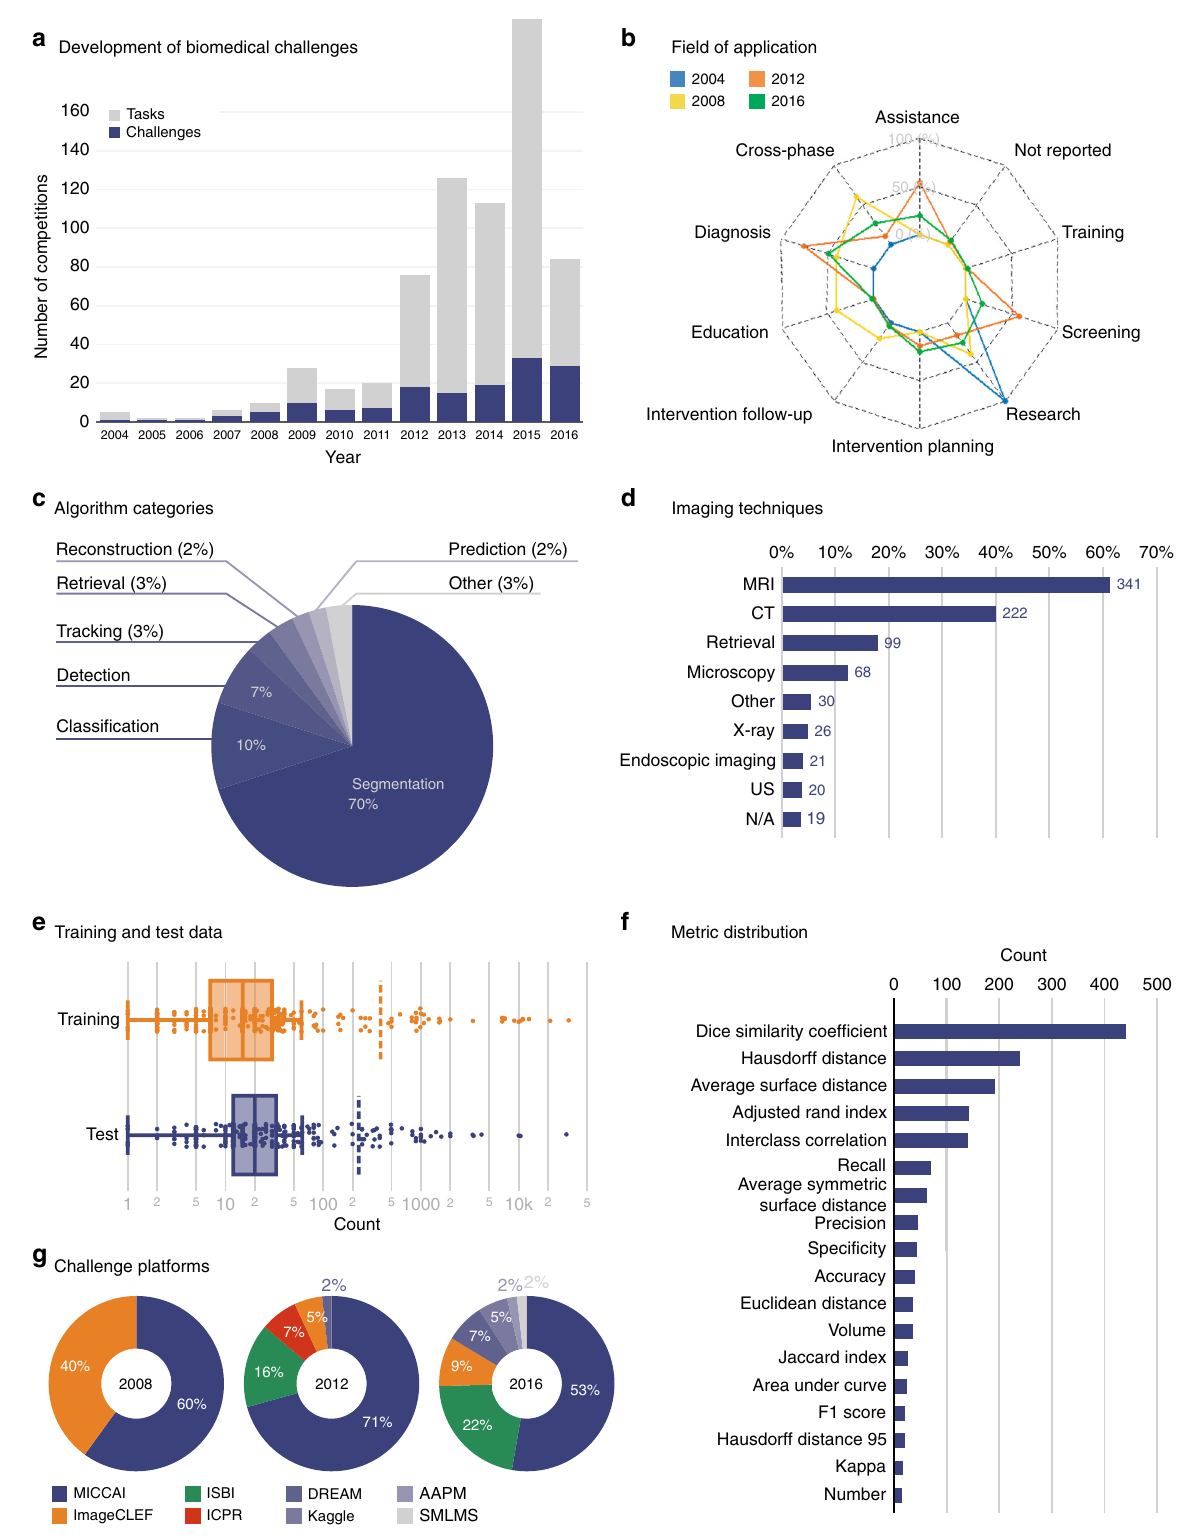
Fig. 1 Overview of biomedical image analysis challenges. a Number of competitions (challenges and tasks) organized per year, b fi elds of application, c algorithm categories assessed in the challenges, d imaging techniques applied, e number of training and test cases used, f most commonly applied metrics for performance assessment used in at least 5 tasks, and g platforms (e.g. conferences) used to organize the challenges for the years 2008, 2012, and